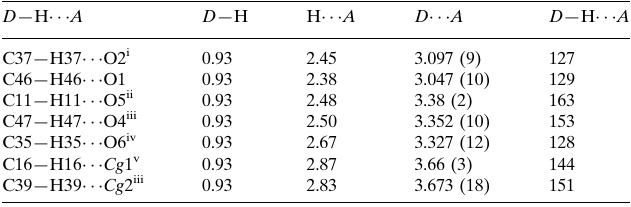
Hydrogen-bond geometry (A˚ , (cid:2)